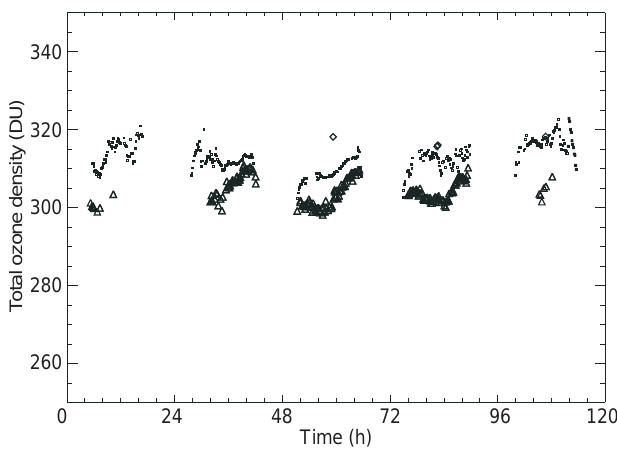
Fig. 3. Ground-based measurements at Tromsø in the period July 27–31, 1996. Diamonds : Dobson measurements; dots : GUV measure- ments; triangles : Brewer measurements